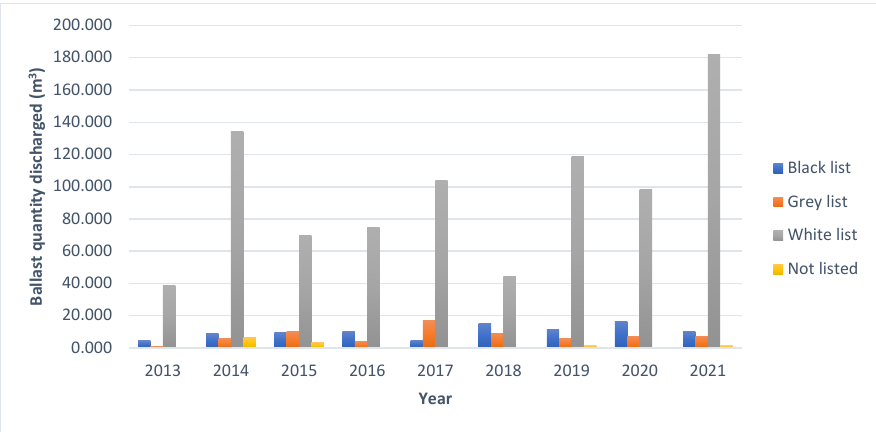
Figure A9. Percentages of BW discharged in the Port of Ploče by Paris MoU White, Grey and Black List flags.